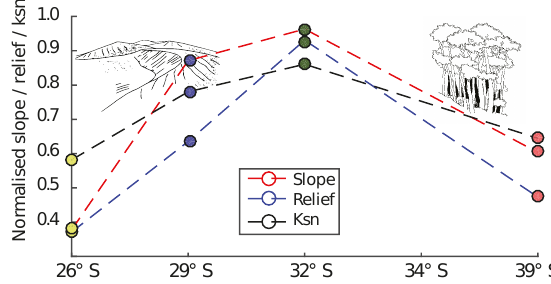
Figure 2. Normalized basin metrics for study areas derived from 30m SRTM digital topography (from the study areas shown in Fig. 1a). Colored dots represent cumulative mean values of normal- ized slope, relief, and channel steepness calculated for all locations using five to eight representative catchments in each area. Dotted lines represent linear interpolation between values. Note the gradual increase, then decrease in all metrics around study area at ∼ 32 ◦ S.